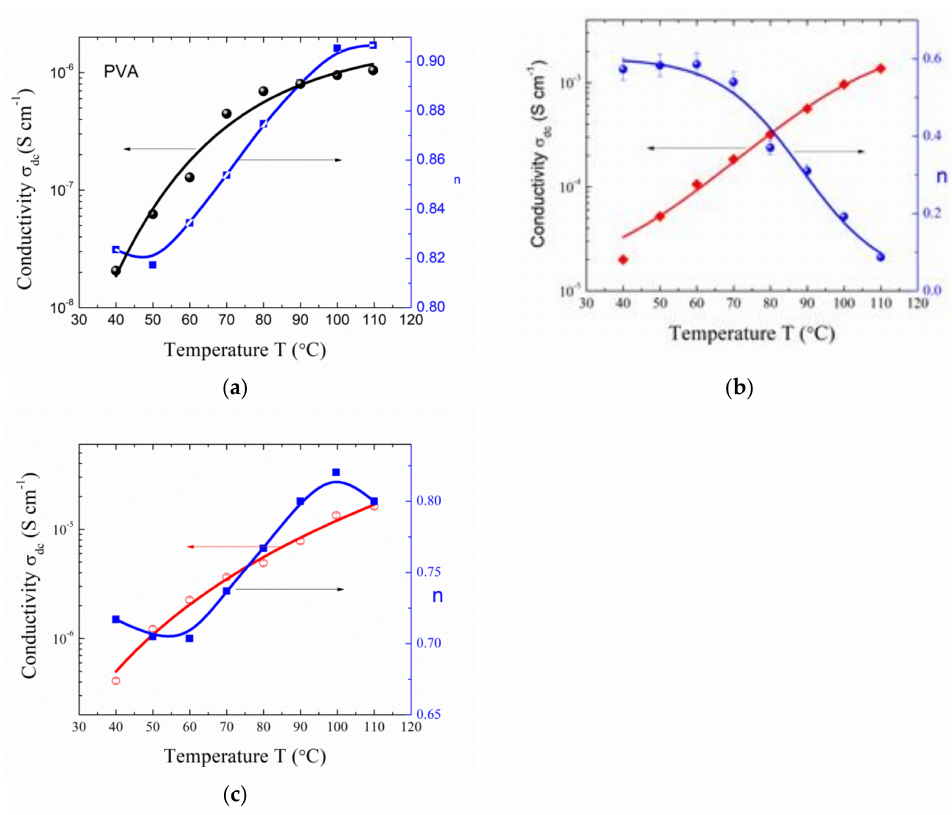
Figure 5. The dc conductivity and ( n ) parameter for PVA ( a ), PVA/LiCl film ( b ) and PVA/AgNO 3 film ( c ) as a function of